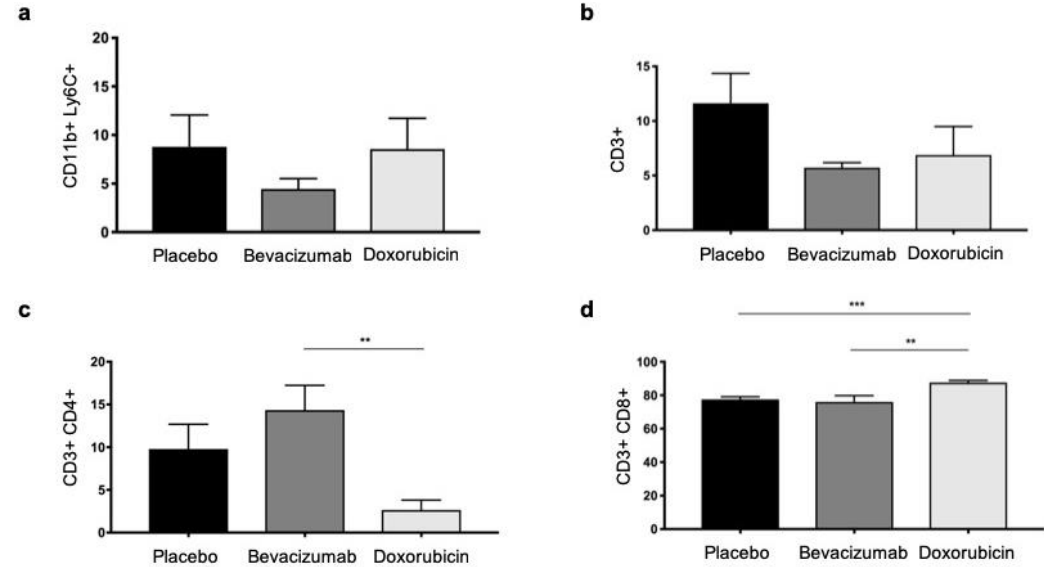
Figure 4. Flow cytometry analyses of the tumor microenvironment (TME). ( a ) The amount of immature myeloid cells (CD11b+/Ly6C+) was similar to the distribution of fluorescence intensities of anti-S100A9-Cy5.5. However, the results were not significant. ( b ) Concerning T cells (CD3+, b), Bevacizumab and Doxorubicin treated tumors had lower cell amounts as compared to placebo. ( c ) T helper cells (CD3+/CD4+) were significantly higher under Bevacizumab as compared to Doxorubicin ( p = 0.005). ( d ) Amounts of cytotoxic T cells (CD3+/CD8+) were significantly elevated under Doxorubicin treatment as compared to Bevacizumab ( p = 0.009) as well as placebo ( p < 0.001). Asterisks indicate significance: ** p < 0.01 , *** p < 0.001 .